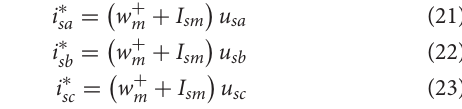
FIGURE 3 | Basic architecture of Adaline neural